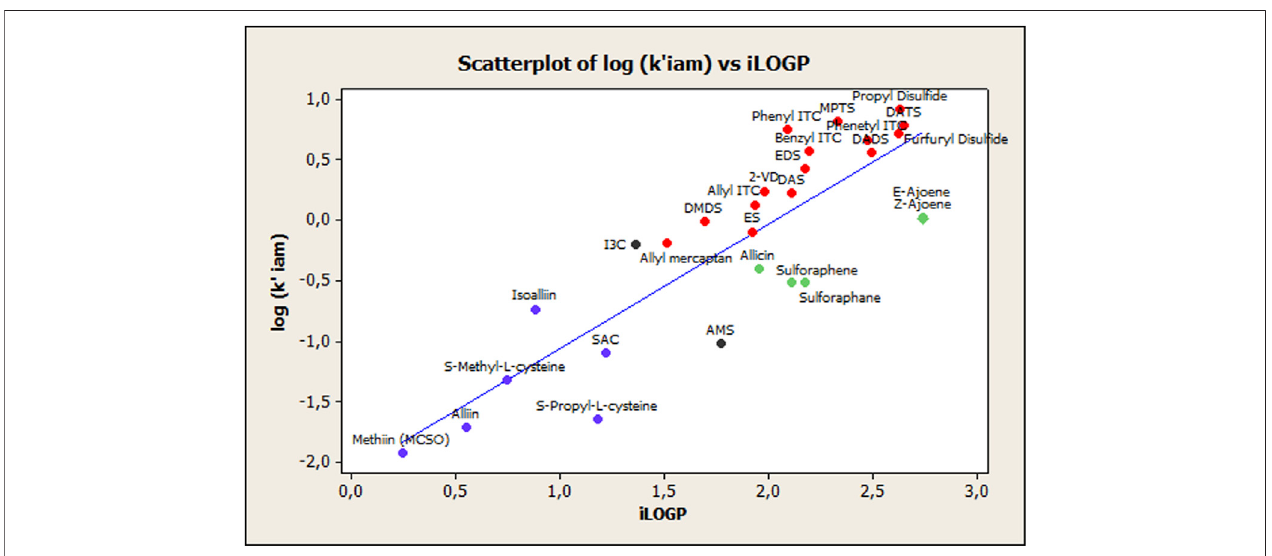
FIGURE 1 | Relationship between log k ’ (IAM) and iLOGP for the 28 compounds shown in Table 1 . Key: Nonionizable organosulfur compounds Ionizable organosulfur compounds Compounds with sulfoxides Unusual observations.